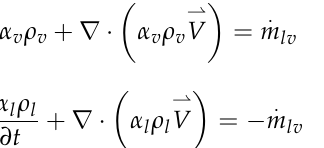
Figure 4. Comparison of bubble volume and relative deviations with different grid cell numbers.